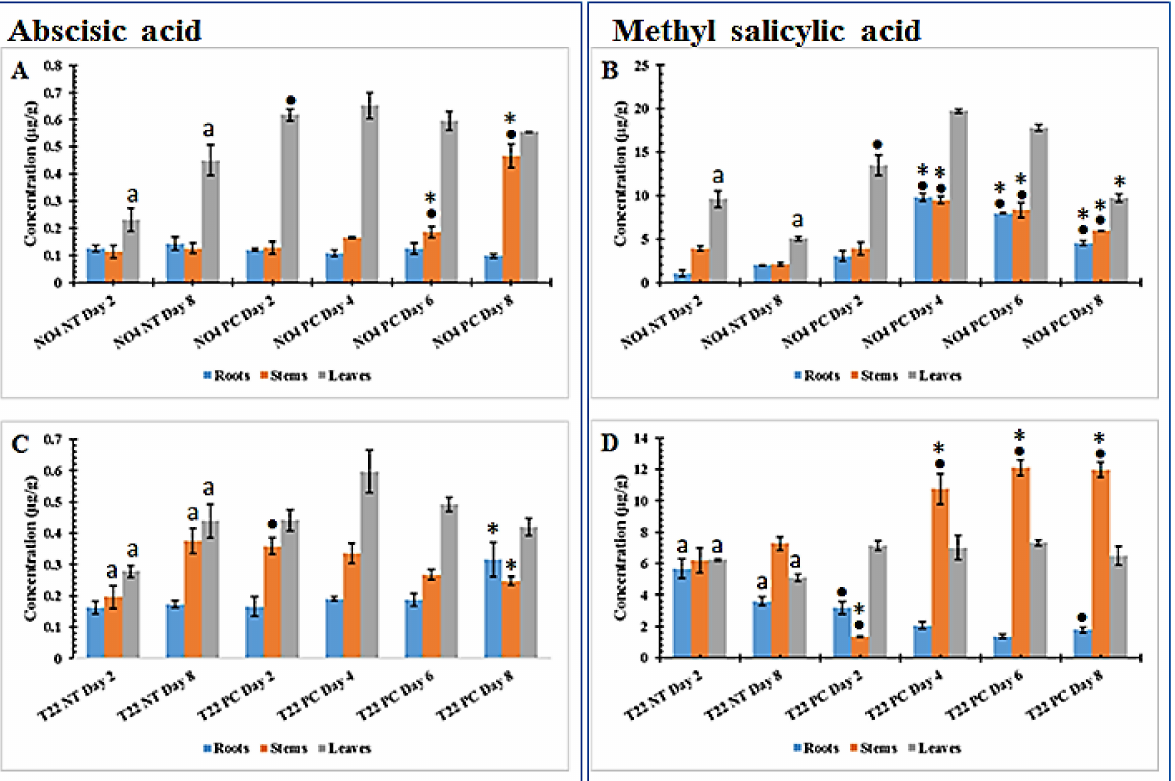
Figure 3. Changes in abscisic acid ( A , C ) and methyl salicylic acid ( B , D ) in PGPR-primed tomato plant tissues harvested at different time points following Phytophthora capsici inoculation. ( A , B ) Pseudomonas fluorescens N04 primed-unchallenged (NT) vs. primed-challenged (PC), ( C , D ) Paenibacillus alvei T22-primed-unchallenged vs. primed-challenged. All concentrations are expressed as µ g/g fresh weight (FW). An asterisk (*) or a dot ( • ) or letter (a) indicates the statistical significance (ANOVA followed by Tukey post-hoc test) with a p -value < 0.05 (Table S5), comparing the PGPR-primed-unchallenged plants and the primed-infected plants. • indicates a comparison between NT day 2 and the primed-challenged plants on days 2–8 and * indicates a comparison between NT day 8 and the primed-challenged plants on days 2–8. The letter “a” indicates a statistically significant difference between the NT controls on days 2 and 8. One-way ANOVA comparing mean values of quantified phytohormones in PGPR-primed-unchallenged vs. PGPR-primed-challenged tomato plant tissues is presented in Table